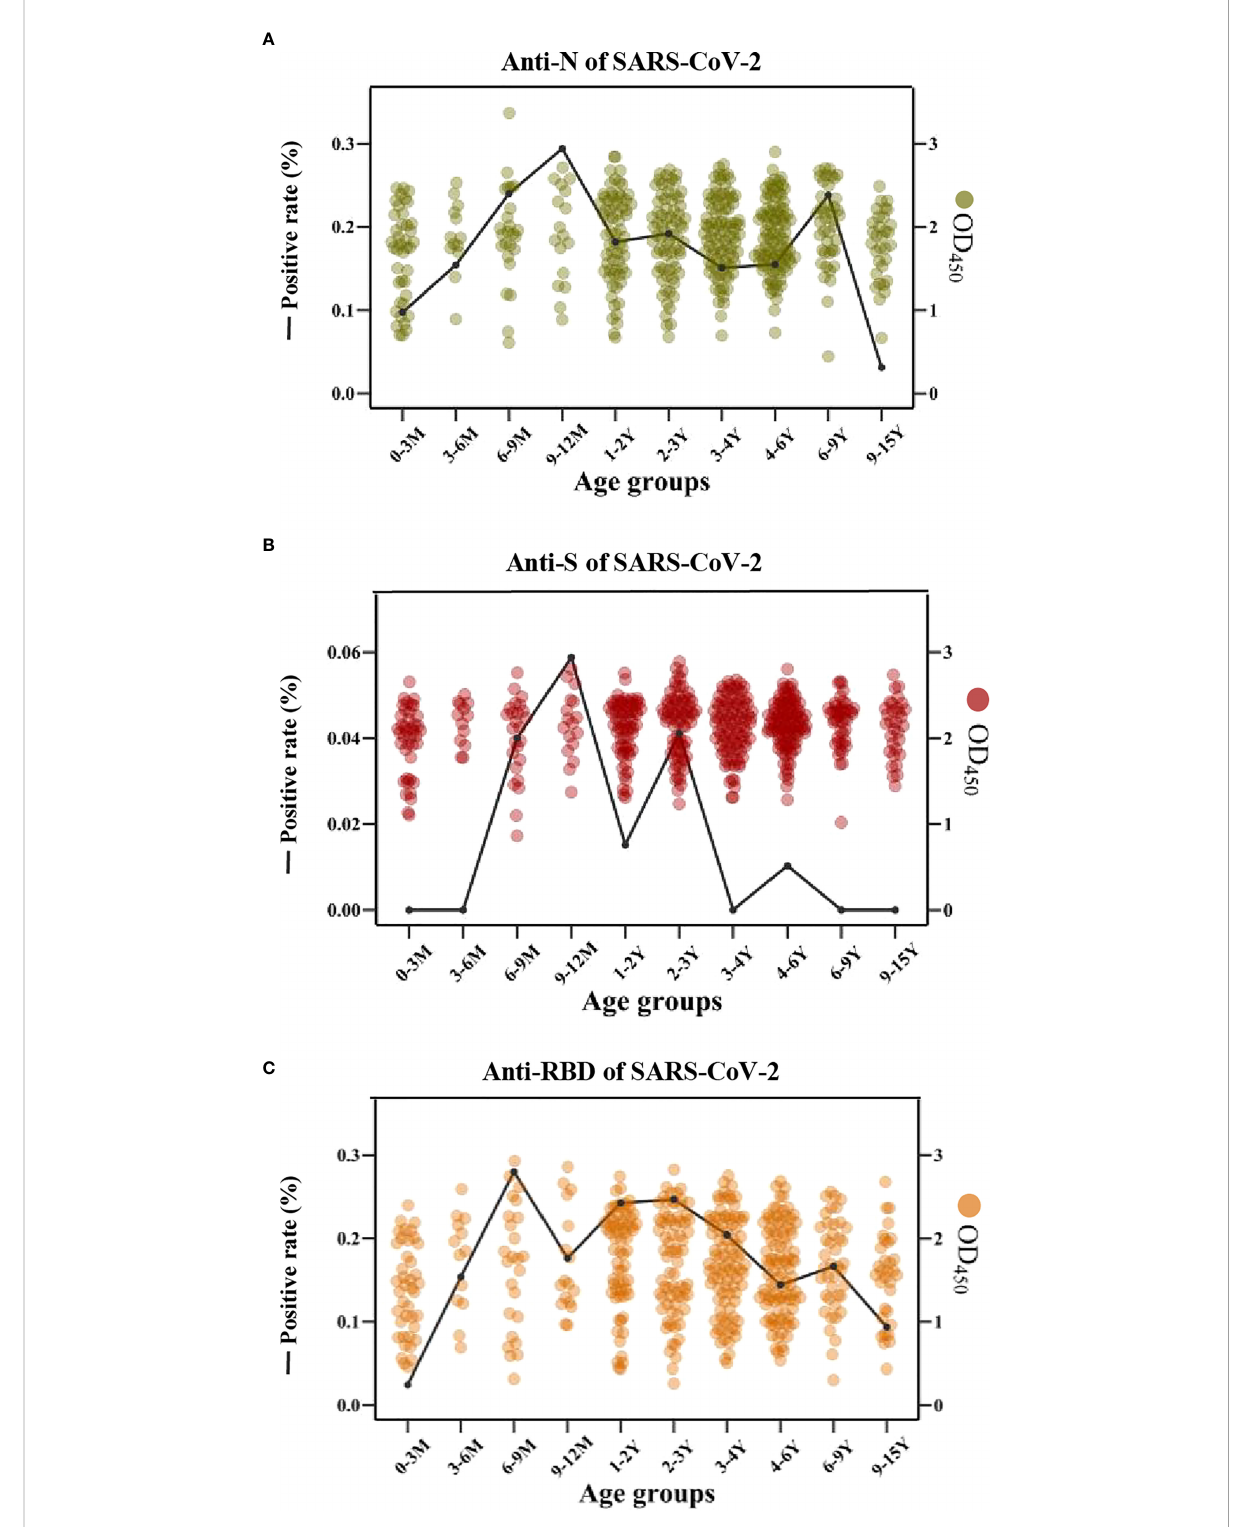
FIGURE 6 The cross-reactive IgG antibodies against SARS-CoV-2 in different age groups with pre-existing antibodies against LPH-CoVs (A-C) The prevalence (line) and OD values (dots) of cross-reactive IgG antibodies against the N (A) , S (B) , and RBD (C) of SARS-CoV-2 in different age